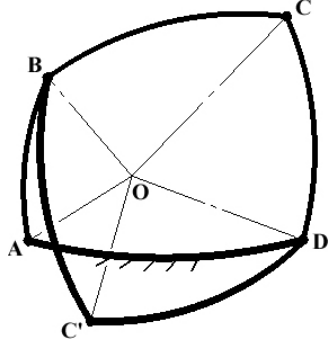
jamming, a branch defect will appear once the driven link in given four coupler orientations locates at different assembly configurations. Actually, the branch of linkage is determined by the solution of motion equation of driven